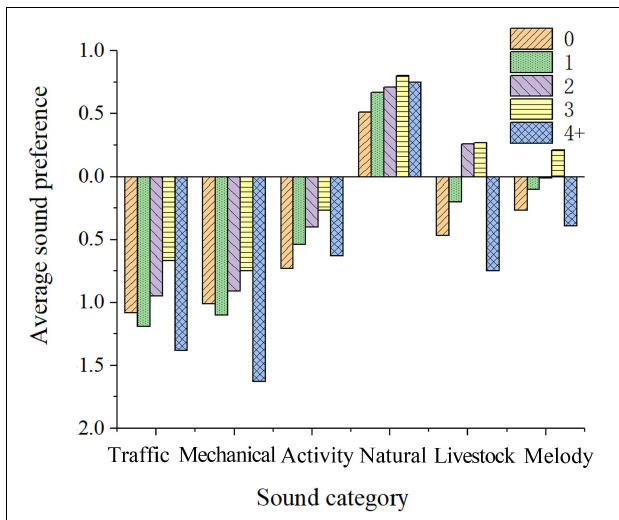
FIGURE 11 | Sound preference of families with different numbers of